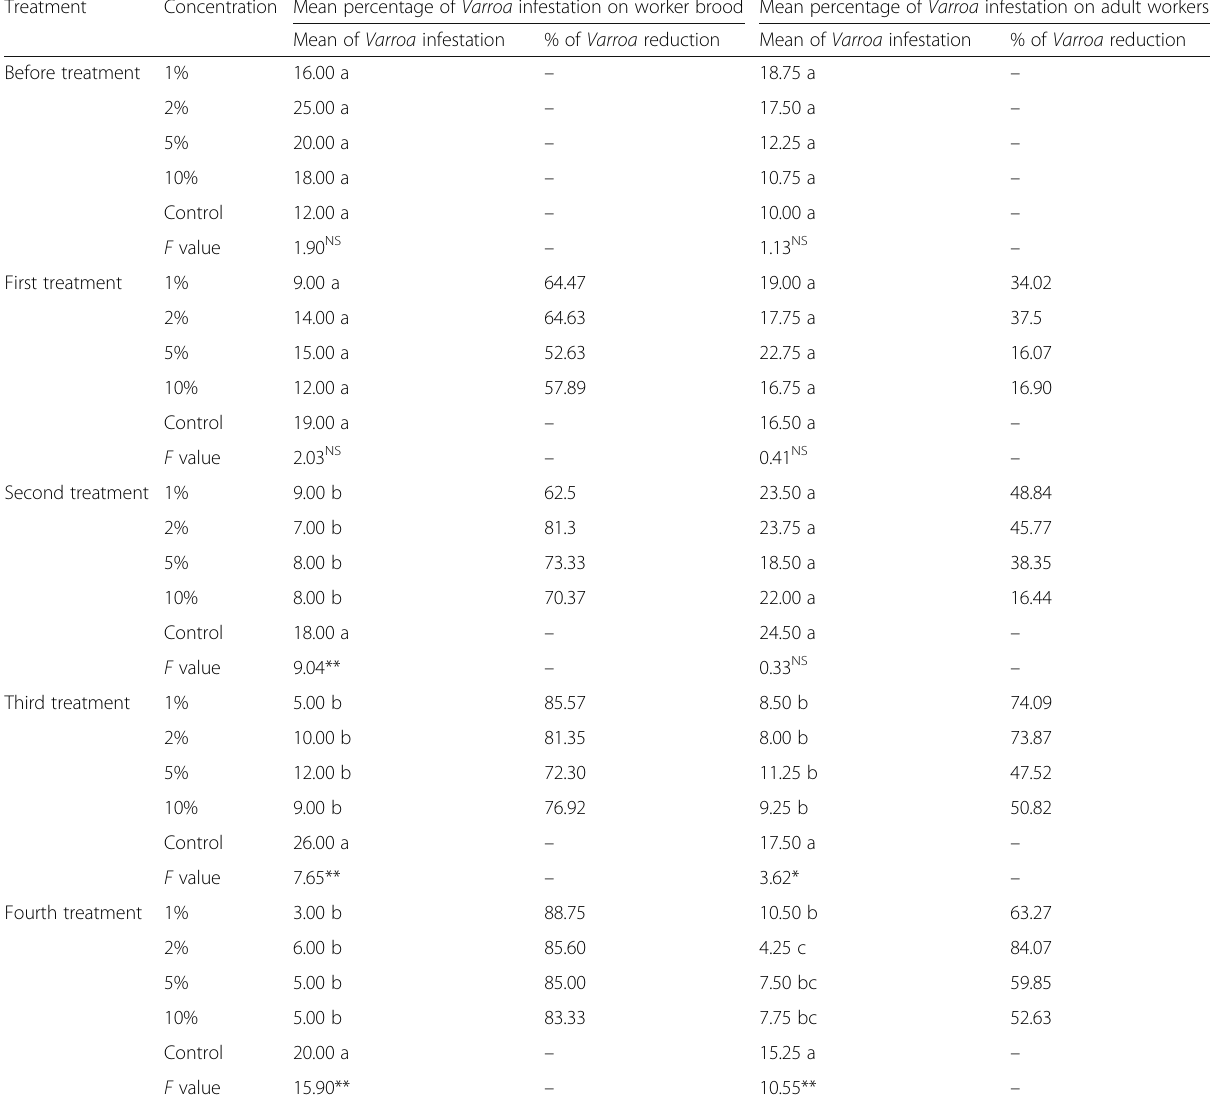
Table 1 Efficiency of different concentrations of jatropha oil on reduction percentage of Varroa mites infestation in honey bee colonies